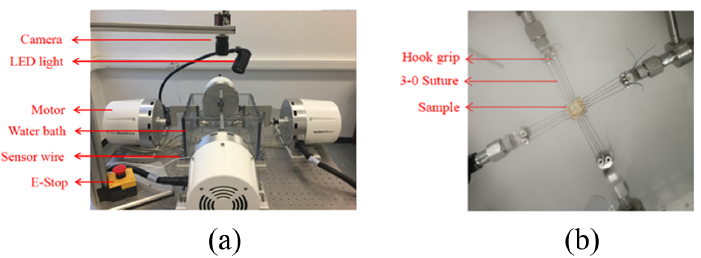
Figure 4. Biaxial tensile test machine. ( a ) Biaxial test bench. ( b ) The sample displacement during the